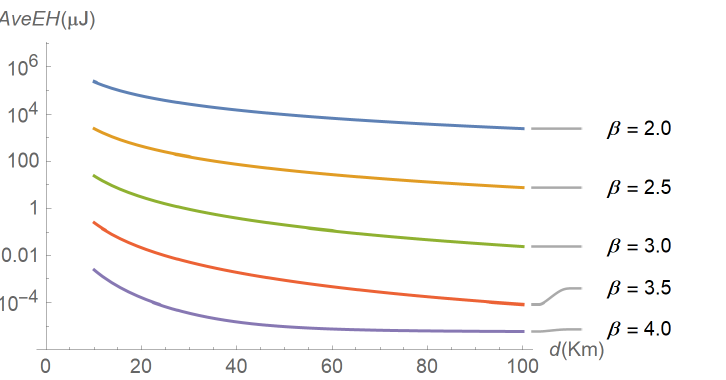
Figure 6. Evolution of the average energy harvested as a function of distance, for different path-loss exponents and a shadowing spread of 8.5 dB.